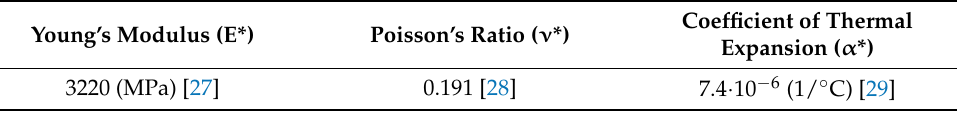
Table 1. Elastic properties from the literature, which were adopted for the calculation of the stress field according to the virtual thermoelastic parameter approach.